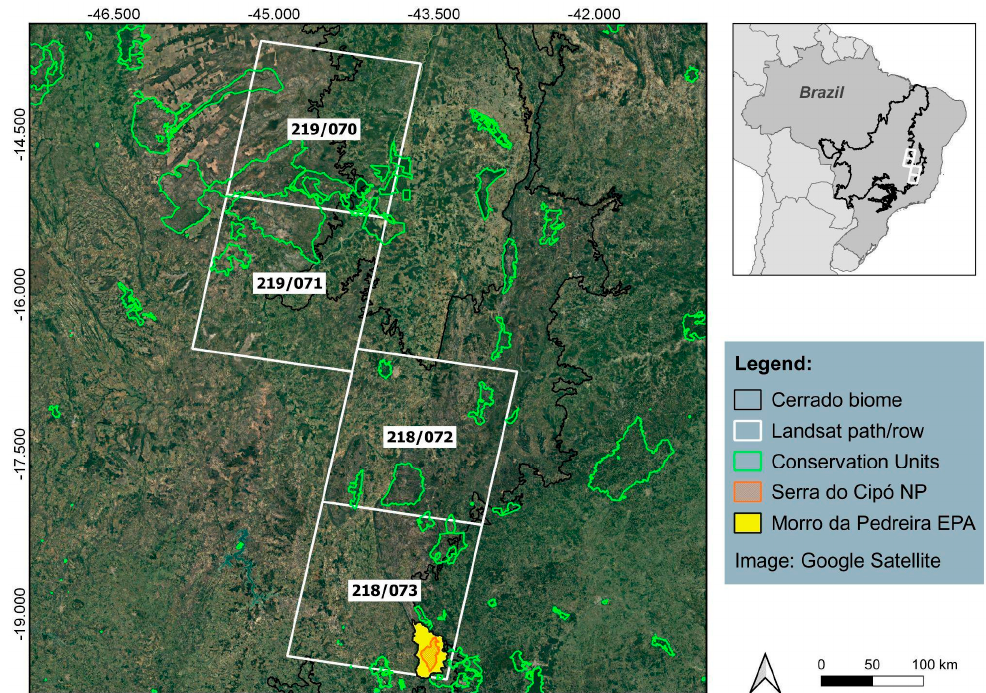
Figure 1. Spatial distribution of the Brazilian Cerrado (black outline in the small image) showing the four Landsat paths/rows (white squares) used in this study, highlighting the two conservation units (Serra do Cipó NP in orange and Morro da Pedreira EPA in yellow) selected as study areas for local evaluation of the algorithm performance. Green polygons indicate the location of the remaining conservation areas.